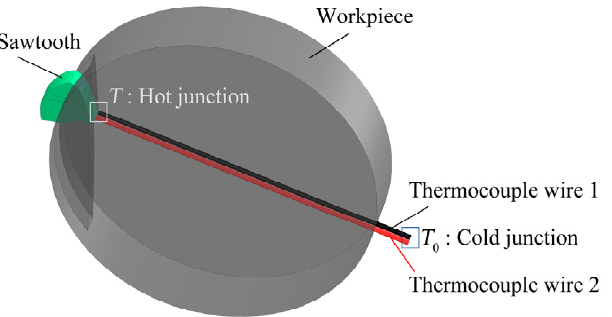
Figure 3. Dynamic artificial thermocouple sawtooth tip temperature measurement.